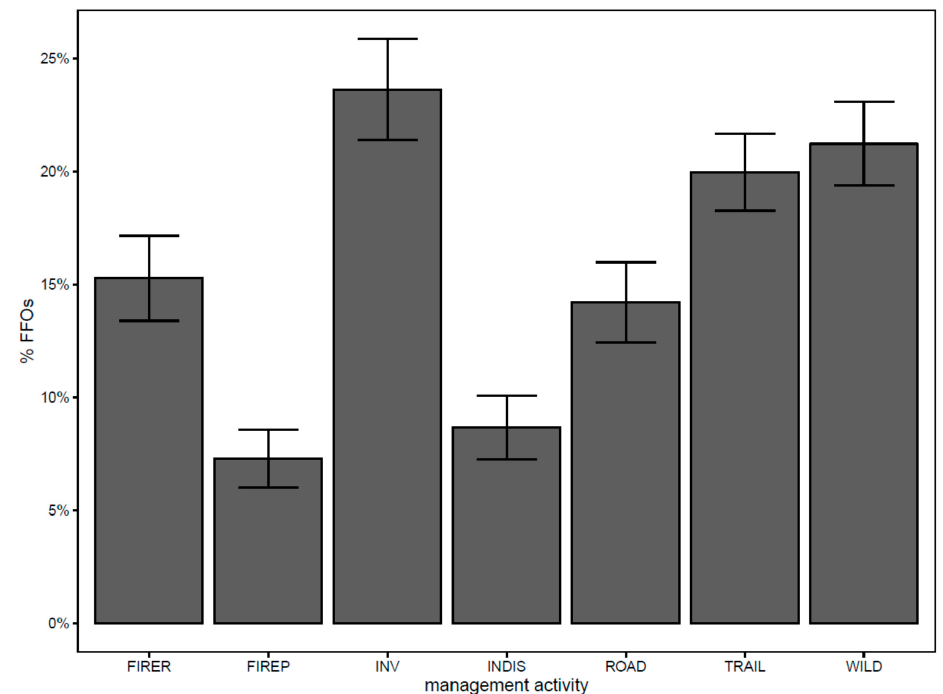
Figure 7. Estimated proportion of family forest ownerships (4+ ha) who have engaged in activities intended to increase the capacity for ecosystem service provision, by management activity, United States, 2011–2013. Error bars represent two standard errors. FIRER = reduced fire hazard, FIREP = controlled burn/prescribed fire, INV = eliminated or reduced invasive plants, INDIS = eliminated or reduced unwanted insects or diseases, ROAD = road construction or maintenance, TRAIL = trail construction or maintenance, WILD = improved wildlife habitat.